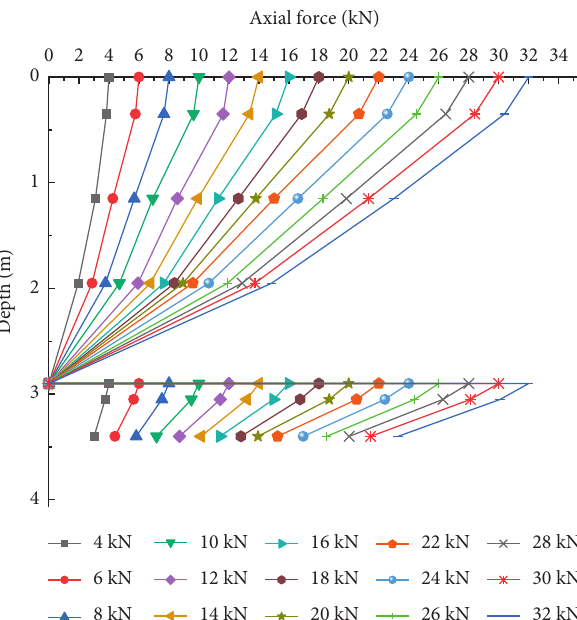
Figure 6: Distribution of axial force of self-anchored test